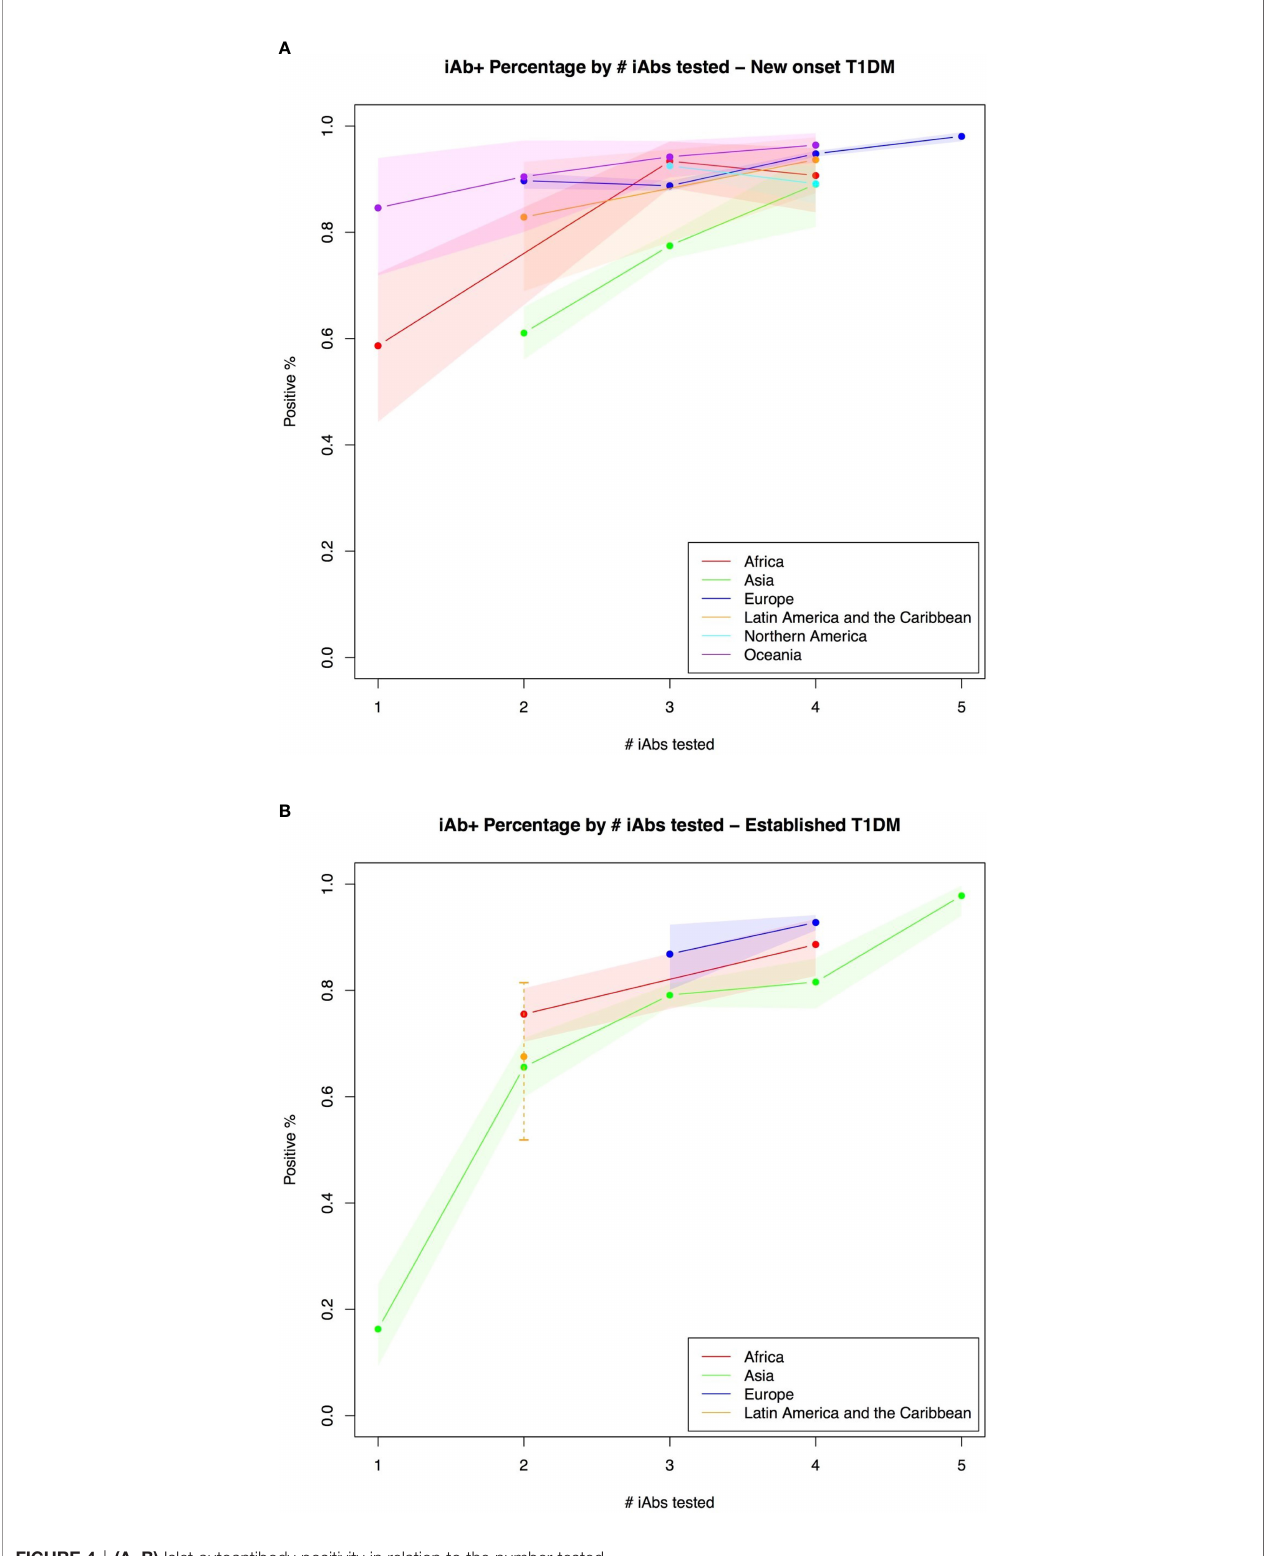
FIGURE 4 | (A, B) Islet autoantibody positivity in relation to the number